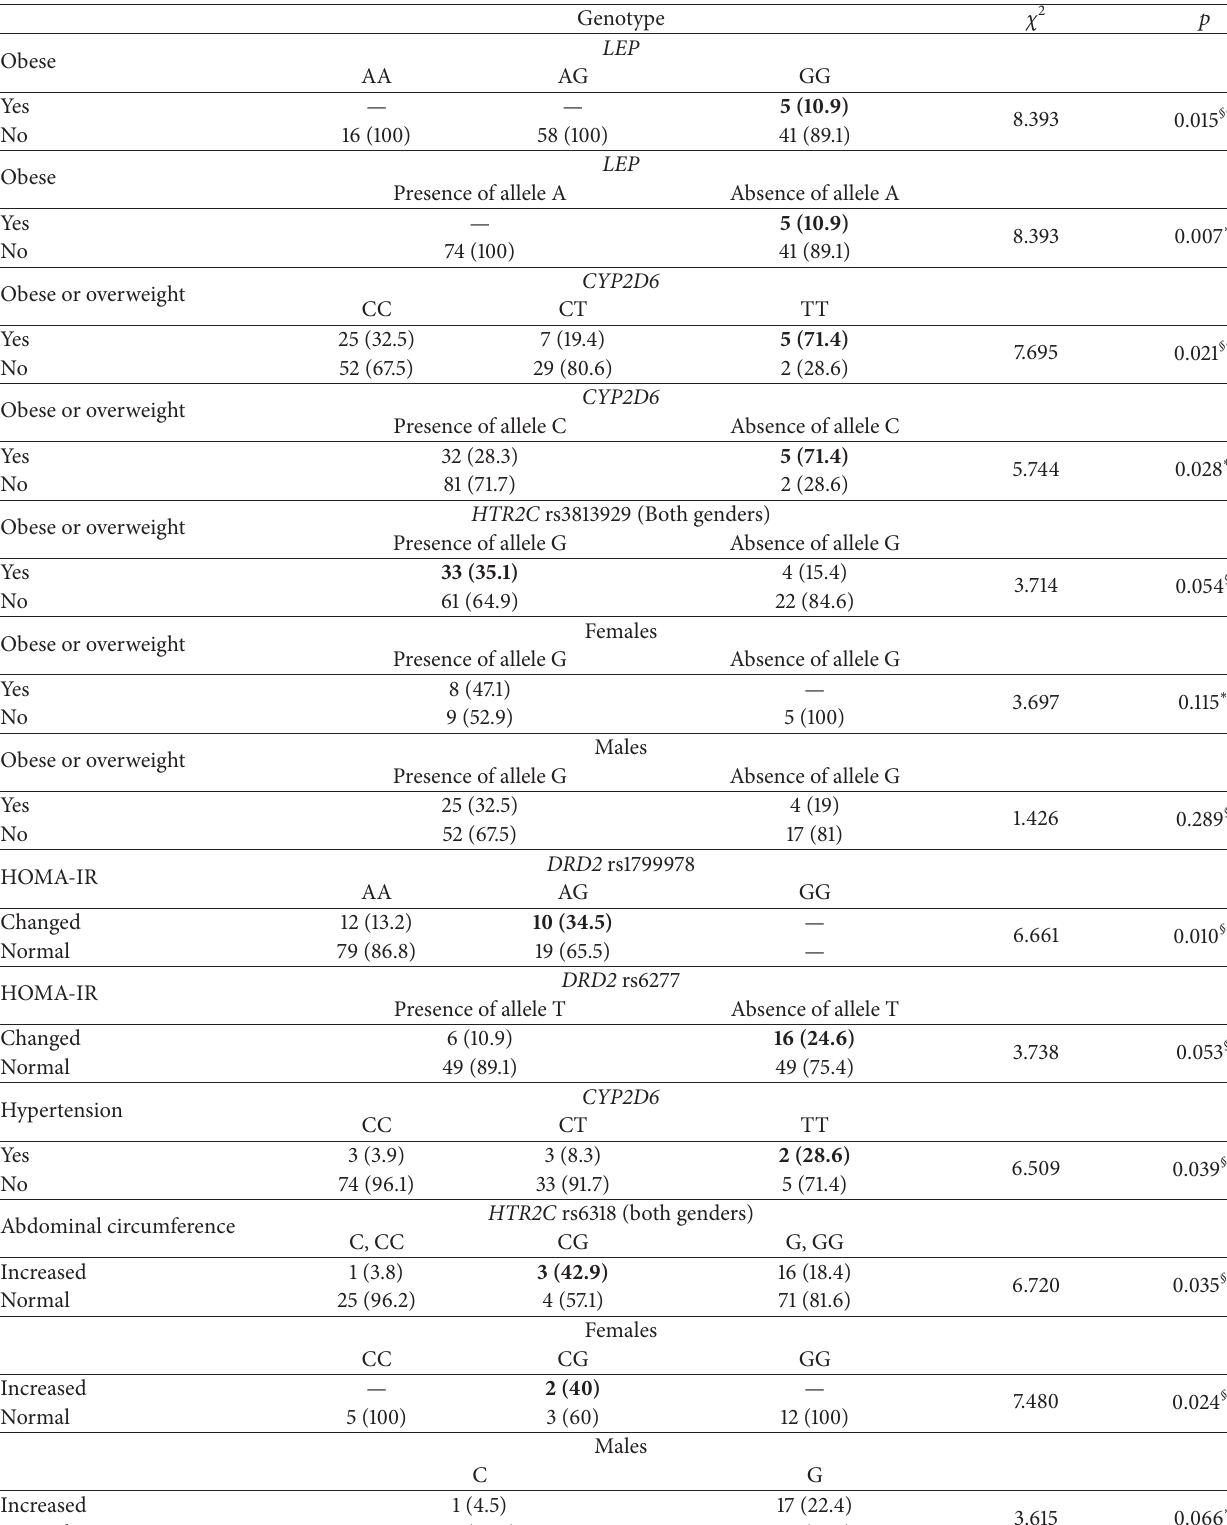
Table 4: Absolute and relative frequencies (%) of alleles of SNPs for the presence or absence of clinical and laboratory changes evaluated as discrete variables ( 𝑛 = 120